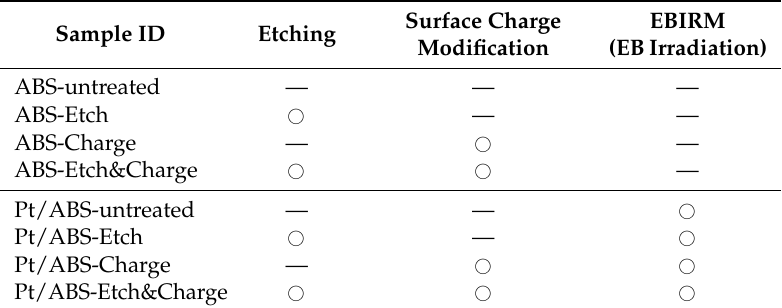
Table 1. Sample condition and